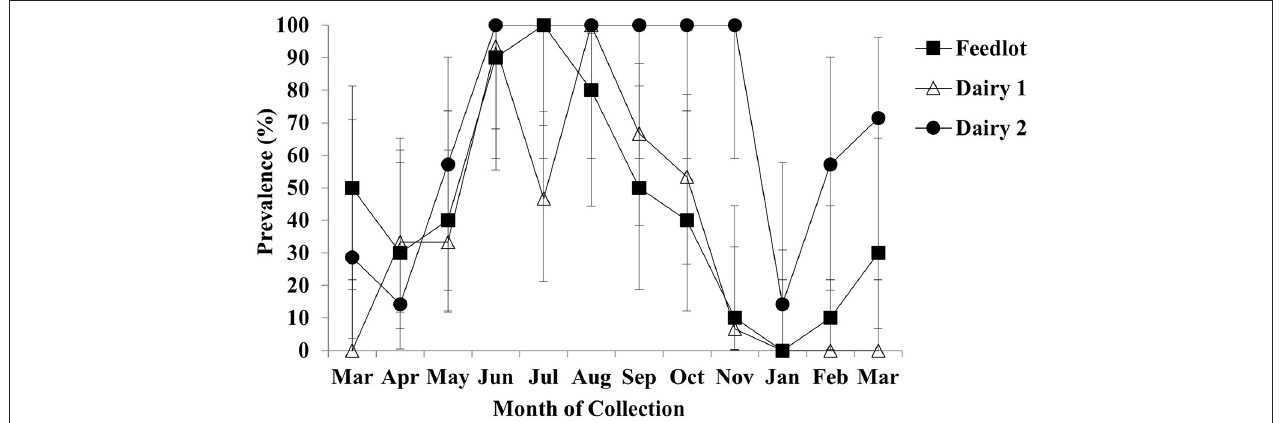
FIGURE 3 | Prevalence of Salmonella in post-enriched water samples by operation and month. Error bars represent 95% confidence